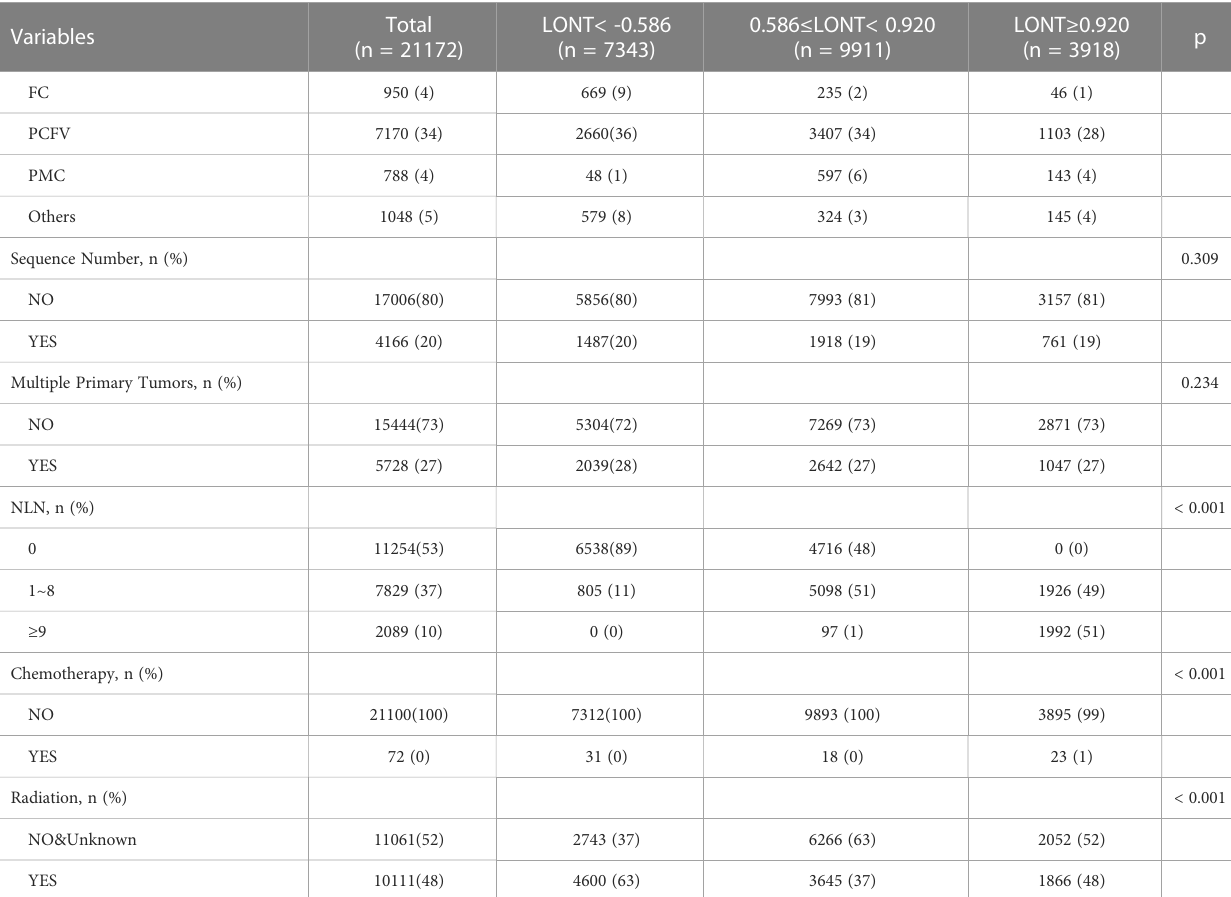
(Figure 1). Univariate and multivariate analyses were undertaken using data from all patients to assess the potential prognostic factors. In the univariate Cox regression analysis, the following factors were associated with shortened OS: age groups of 66 – 74 years and >75 years ( vs . 55 – 65 years), male sex, black ethnicity ( vs . white ethnicity), marital status of widowed/other ( vs . married), grade of II, III, or IV ( vs . I), stage of T2, T3, T4a, or T4b ( vs . Ia), N1 stage ( vs . N0), grade of III – IV ( vs . I – II), tumor diameter of 2 – 4 cm or >4 cm ( vs .<1 cm), multiple primary tumors, and high NLNs. LONT >0.920 was an independent protective factor for OS (HR, 0.756; 95%CI, 0.589 – 0.97, P =0.028) based on multivariate Cox regression analyses after adjustment for baseline demographic and clinical features (Figure 2). The fl oating absolute risk method provides the variance in the logarithm of the hazard ratio for each category (including the reference category) to facilitate comparisons among the different LONT categories (Table 2). Compared with the OS values of the -0.586 to 0.920 group, the adjusted HR for LONT >0.920 was 0.756 (95%CI, 0.589 – 0.97). Strati fi ed analyses showed the HRs for OS across two LONT groups strati fi ed by demographic and clinicopathologic features (Figure S2). The association between LONT and OS remained signi fi cant for male sex (P =0.026), black ethnicity (P =0.033), marital status